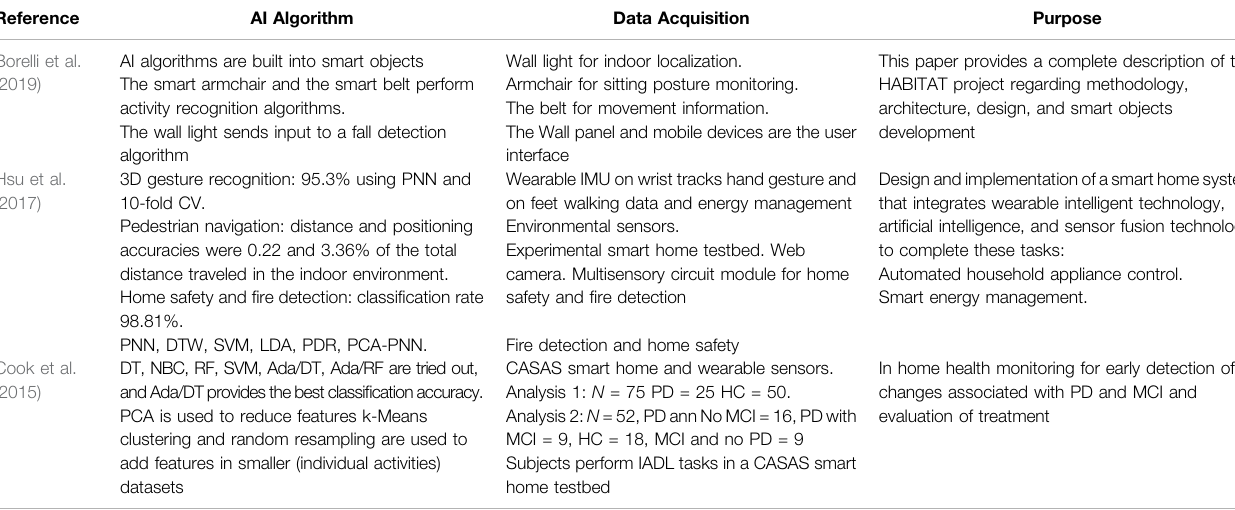
TABLE 13 | Smart home applications. Reference AI Algorithm Data